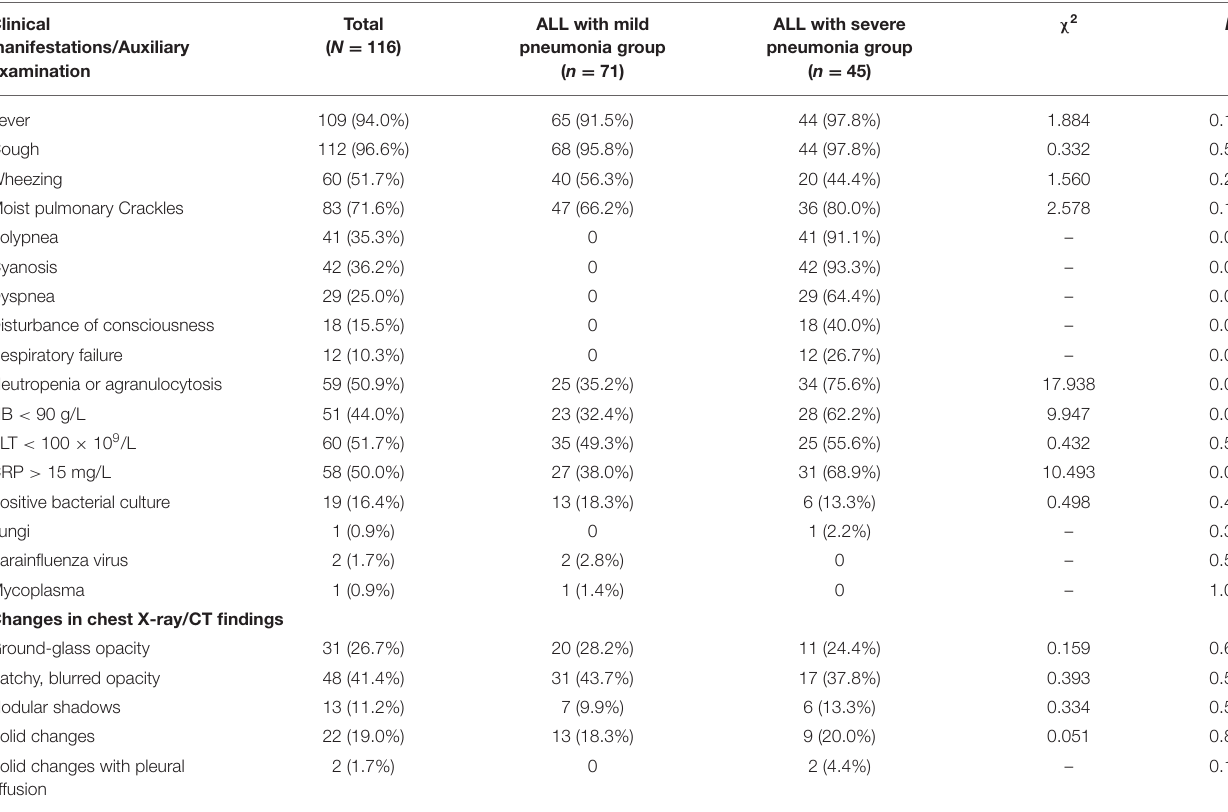
TABLE 2 | Comparison of clinical manifestations and auxiliary studies between ALL patients with mild pneumonia and ALL patients with severe pneumonia. Clinical manifestations/Auxiliary